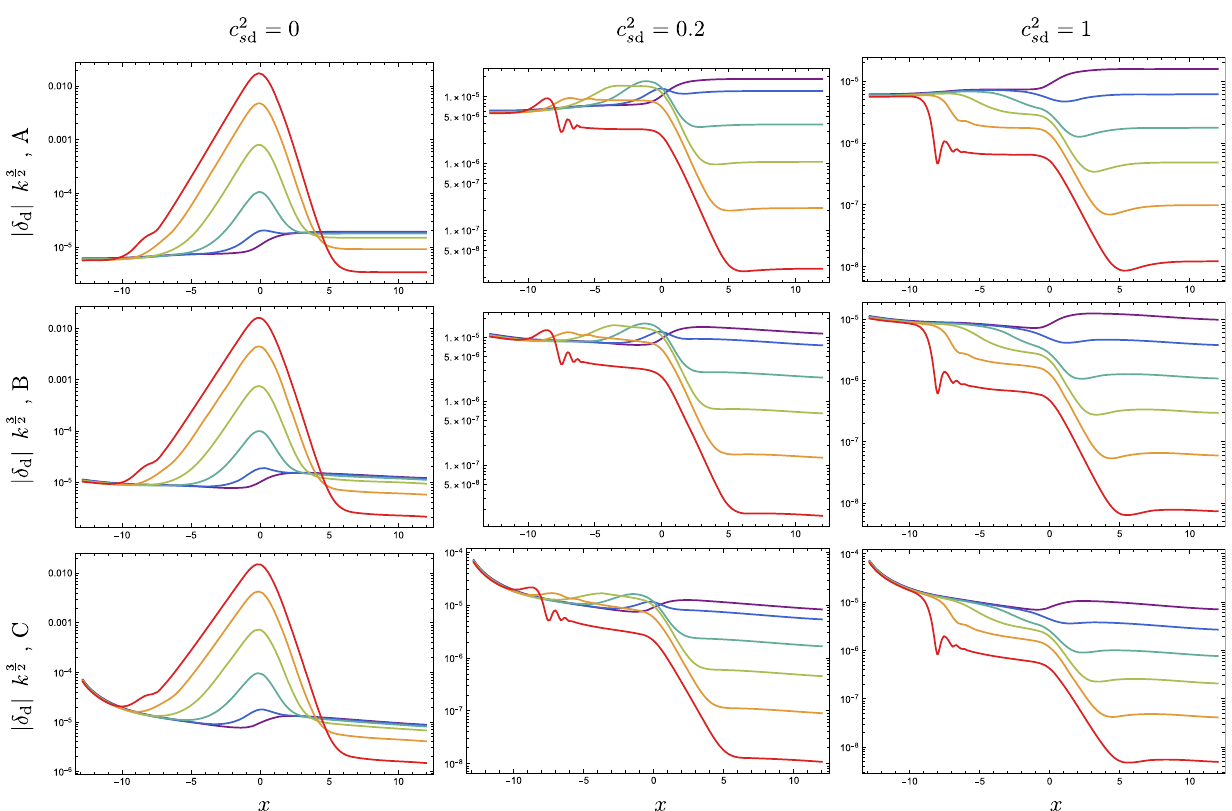
Fig. 3 These plots show the evolution of DE density contrast for dif- goes from well inside the radiation dominated epoch, x (cid:9) = − 12 . 84, to ferent models and different values of c 2 the far future, x = 12. Each colour corresponds to a particular value . The panels of the first, second s d of the wave-number k : k 1 = 3 . 33 × 10 − 4 h Mpc − 1 (purple), k 2 and third row correspond with the model A, B and C, respectively. The panels of the first, second and third columns correspond, respec- = 0, c 2 = 0 . 2 tively, to the values of the squared speed of sound c 2 s d s d = 1. The plot is drawn as a function of x = ln ( a ) which and c 2 s d